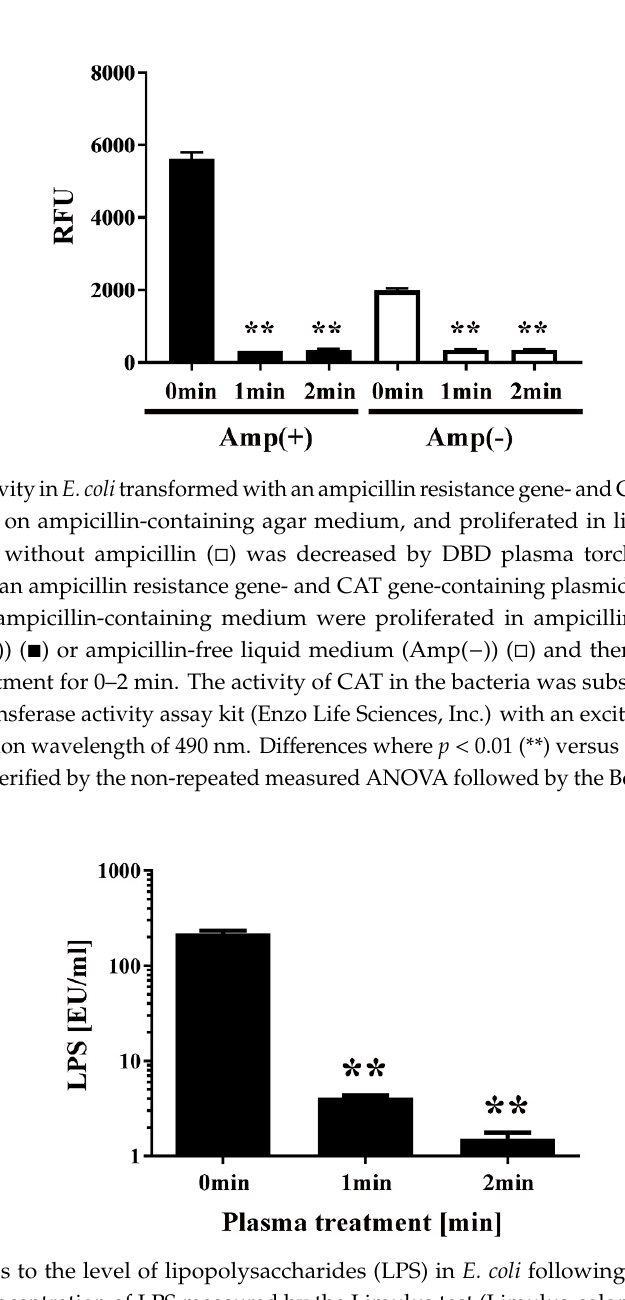
Figure 7. Changes to the level of lipopolysaccharides (LPS) in E. coli following DBD plasma torch treatment. The concentration of LPS measured by the Limulus test (Limulus-color KY test, Wako Pure Chemical Industries Ltd., Osaka, Japan) is expressed as endotoxin units (EU) per mL. LPS level was reduced after plasma treatment for 0–2 min. Di ff erences where p < 0.01 (**) versus control (0 min) were considered significant when verified by the non-repeated measured ANOVA followed by the Bonferroni correction.